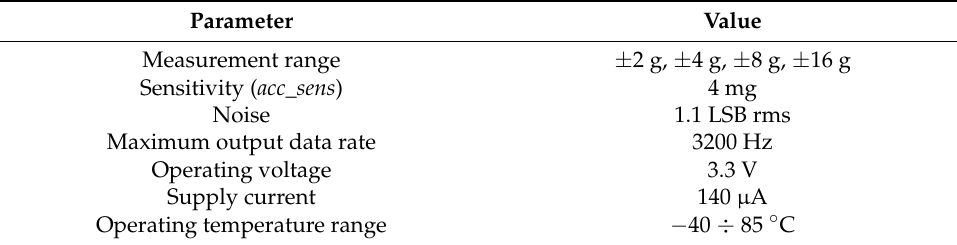
Table 1. Main characteristics of the MEMS accelerometer adopted for the sensor nodes.